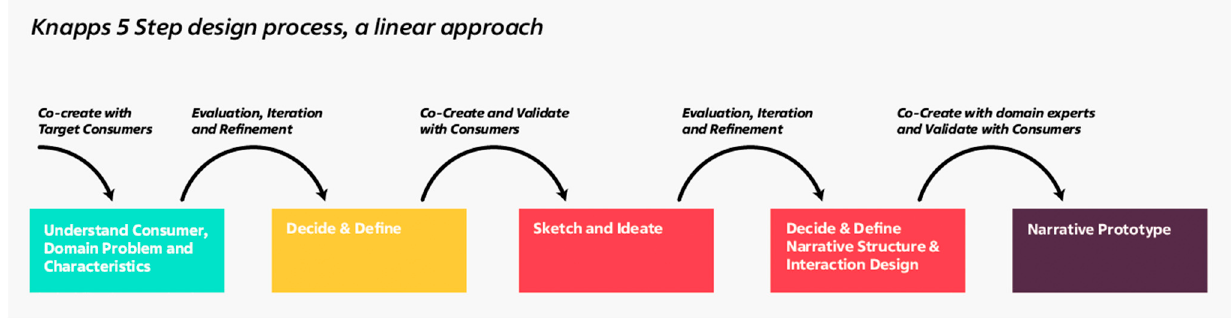
Figure 3. 5-step design process according to Knapp et al.